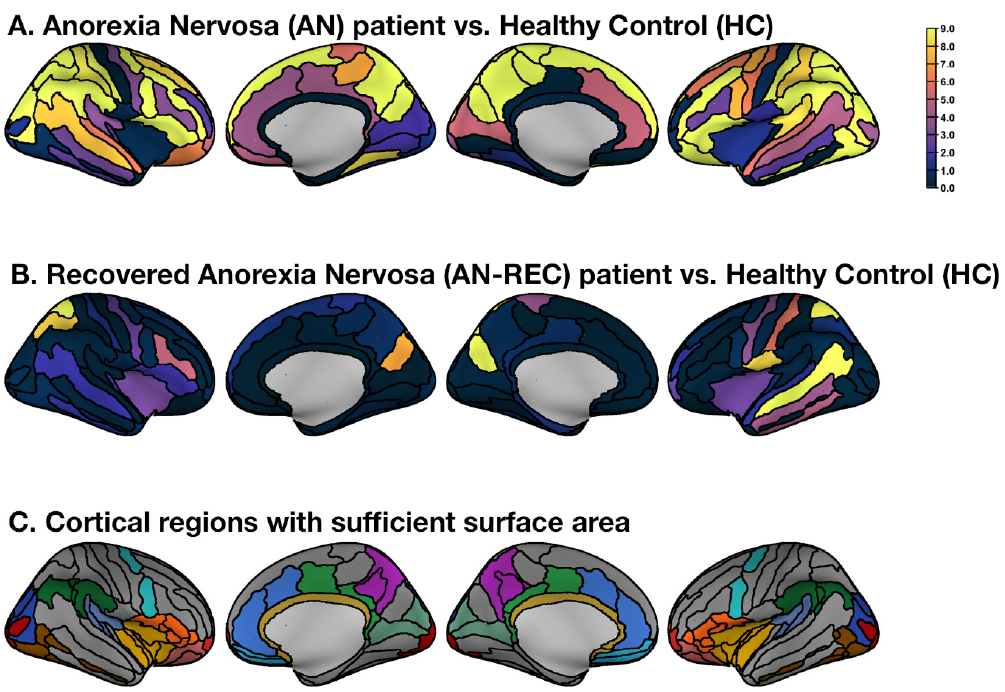
Figure 3. Unthresholded group comparison (F-statistics) plotted on the inflated cortical surface for the combined regions. ( A ) Regional F-statistics comparing Anorexia Nervosa (AN) patients and Healthy Controls (HC). ( B ) Regional F-statistics comparing recovered Anorexia Nervosa (AN-REC) patients with Healthy Controls (HC). ( C ) All cortical regions were included in the analysis. Regions shown in color were recombined with respect to the original Destrieux atlas to yield sufficiently large surfaces areas; colors match the labels and areas shown in Figure 2.